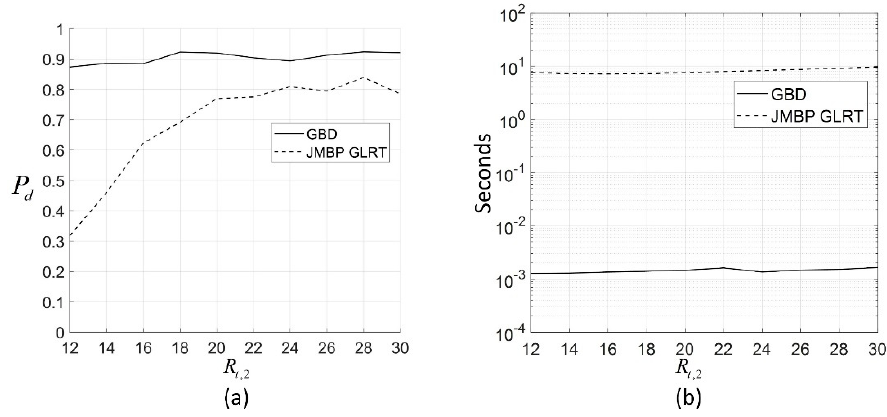
Figure 3. ( a ) P d of the two algorithms for different R t ,2 with R t ,14 = 16 dB, c 14 = 0.3, η 1 = − 0.5, and R t ,1 l = 16 dB, c 1 l = 0.3, η 1 = − 0.5, where the P d of the two algorithms are calculated under the same false alarm rate P fa ≤ 0.02; ( b ) average computation time of the two algorithms for each R t ,2 with the same parameters set as ( a ); the algorithms are programmed by MATLAB on a PC with Intel Core i5-6300 CPU @ 2.4 GHz, 4 GB memory, and a Windows 10 operation system; interior-point algorithm is used to solve the maximum likelihood (ML) estimation in JMBP GLRT, with the initial search point being the true values of the target parameters.